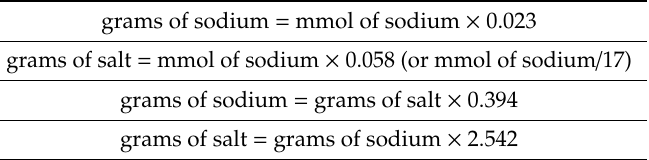
Table 1. Formulas to convert sodium in salt (sodium chloride) and vice versa, according to units of